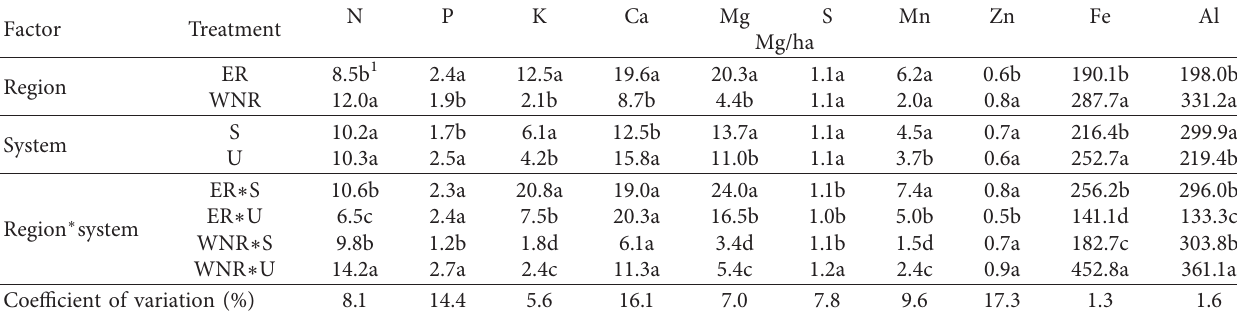
Table 4: Soil (0– 60cm depths) nutrient stocks in cocoa ecosystems ( n �